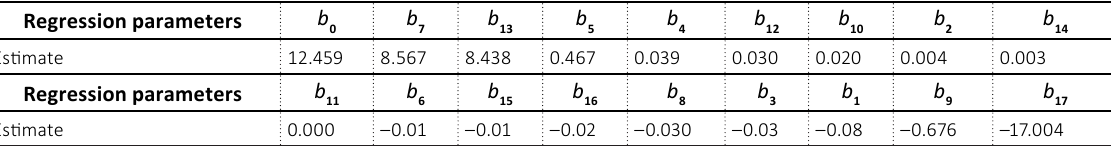
Table 3. Regression coefficients for the 17